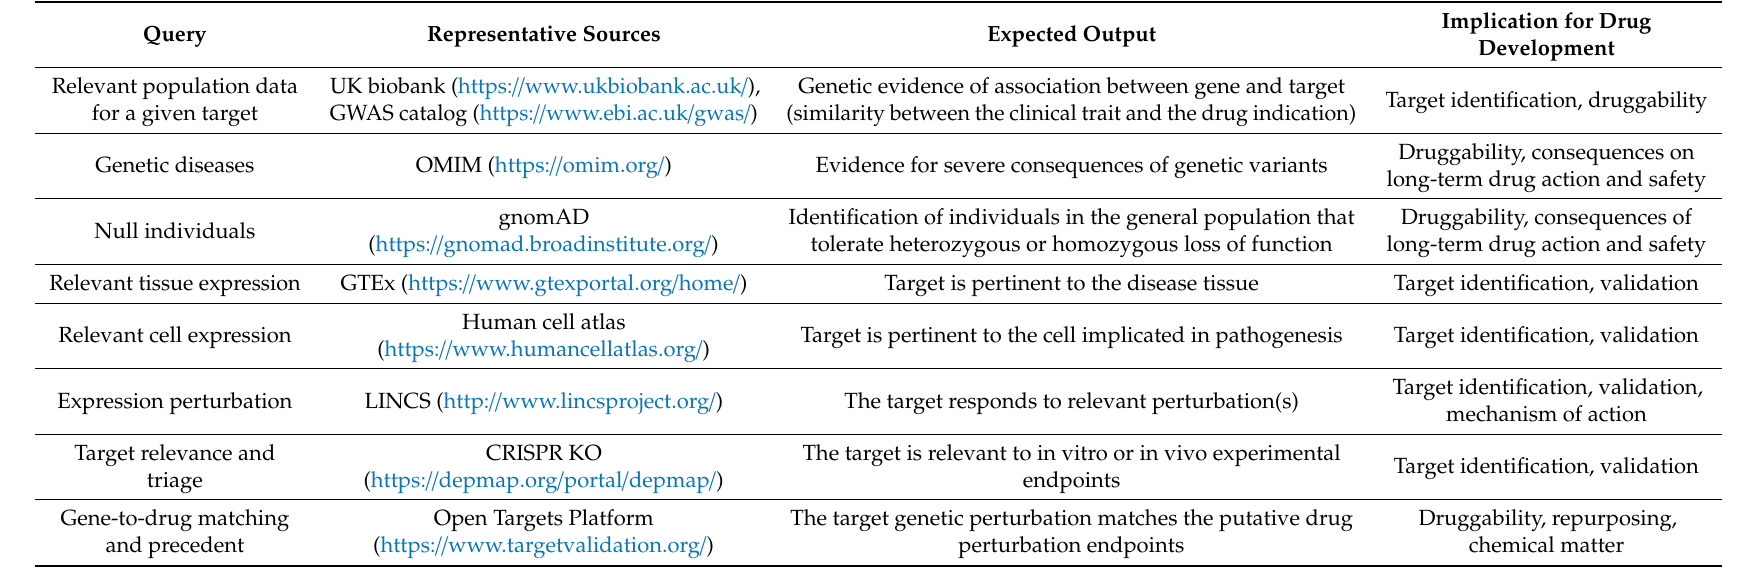
Table 1. Genomic data impacting target identification and drug development. Common uses of genomic, transcriptomic and CRISPR editing data in industry. This table describes selected queries and representative sources based on the mature techniques described in this